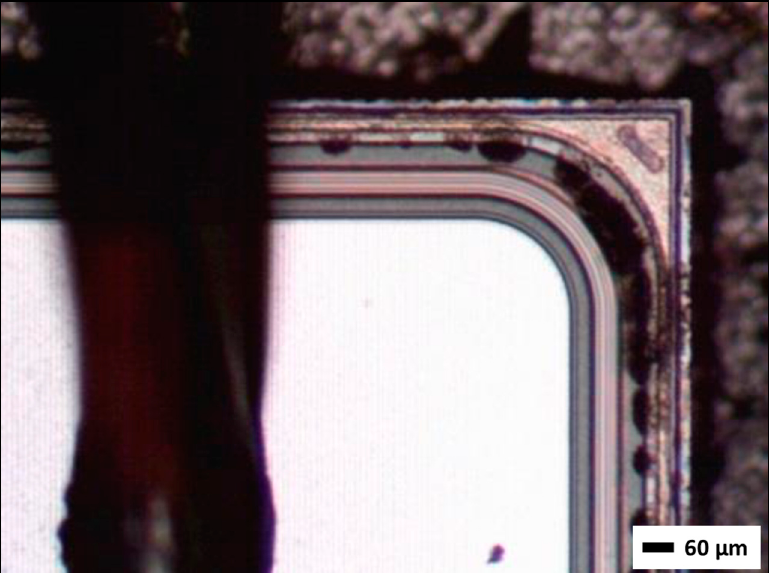
Figure 8. Top view of a decapsulated MTP module showing polyimide blistering (darker spots) after HV-THB testing. Device degradation is concentrated on the surface of the junction termination. Figure reproduced with permission from [6].